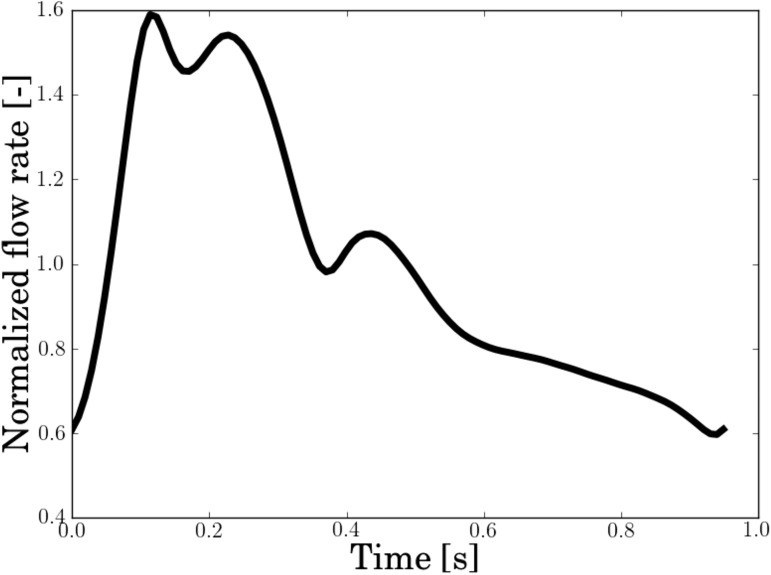
The figure illustrates the differences between the coarsest resolution on the left, and the finest resolution on the right.The clip is done just upstream from the aneurysm of model 1. The black dots represent points at which the velocity is computed.